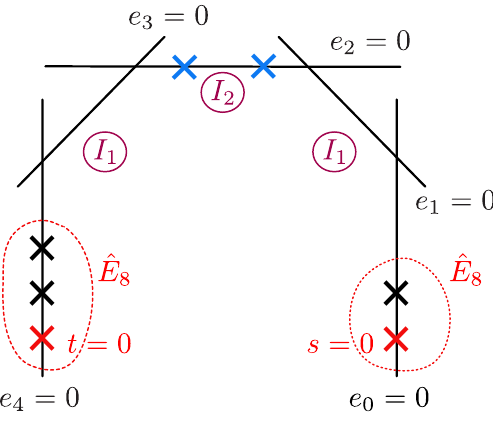
Figure 9 . Kulikov Type III degeneration of E 7 × E 8 Weierstrass model (4.34) for generic value of the parameter x and b = 0 1